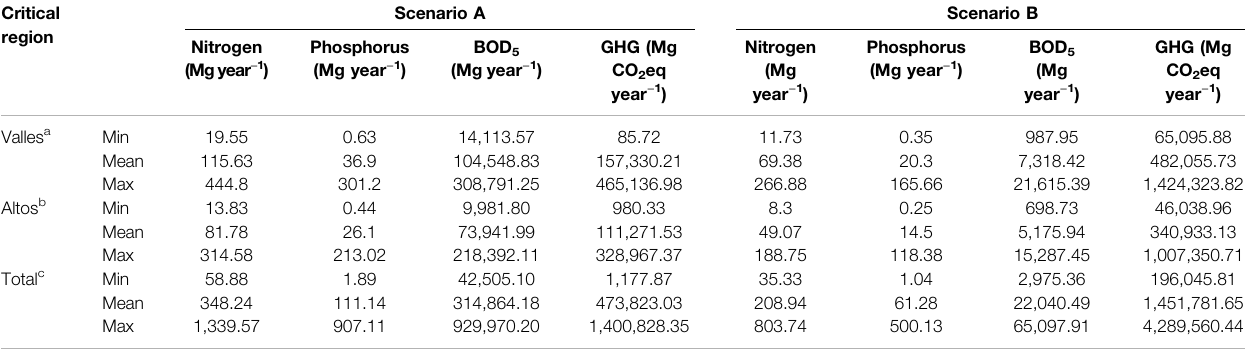
TABLE 8 | Pollutant discharge potential values calculated for the established critical regions under scenarios A and B. Critical